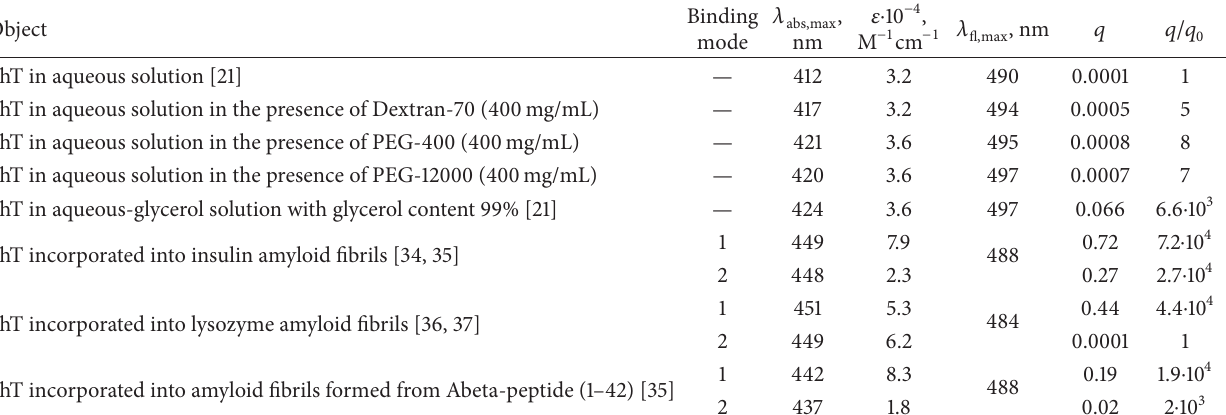
Table 1: Spectral properties of ThT in the presence of crowding agents ∗ .